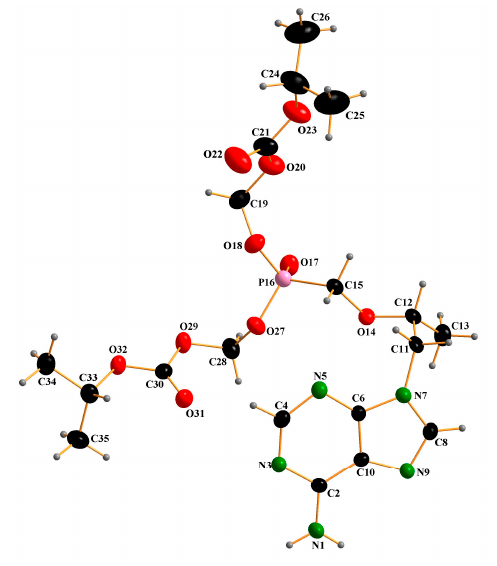
Figure 2. Molecular structure of Tenofovir disoproxil (TD). The displacement ellipsoids are drawn at the 20% probability level.